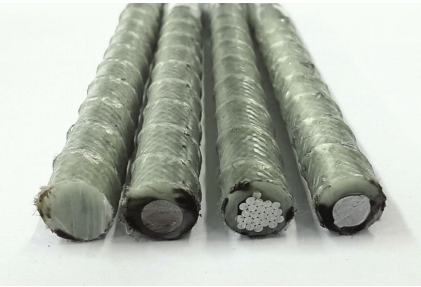
Figure 6: The cross section view of FRP Hybrid Bar.